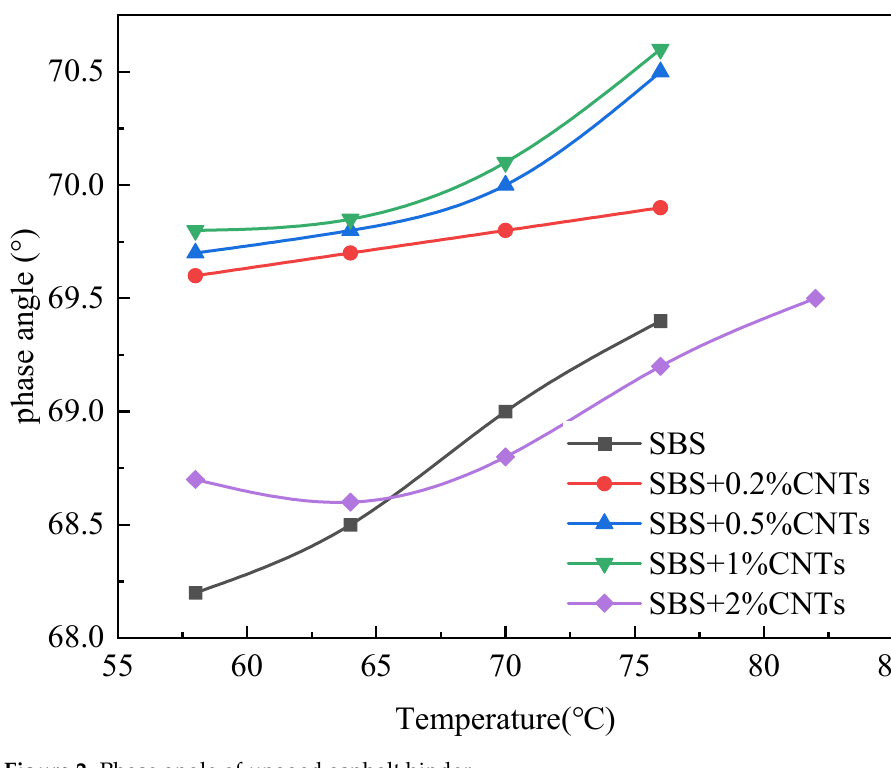
Figure 2. Phase angle of unaged asphalt binder.